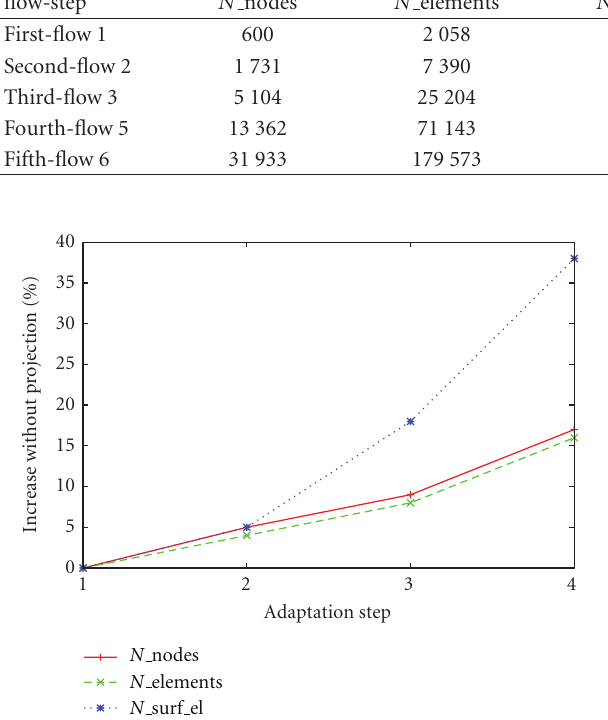
Figure 13: Percentage di ff erence between mesh characteristic sizes of adaptations with and without